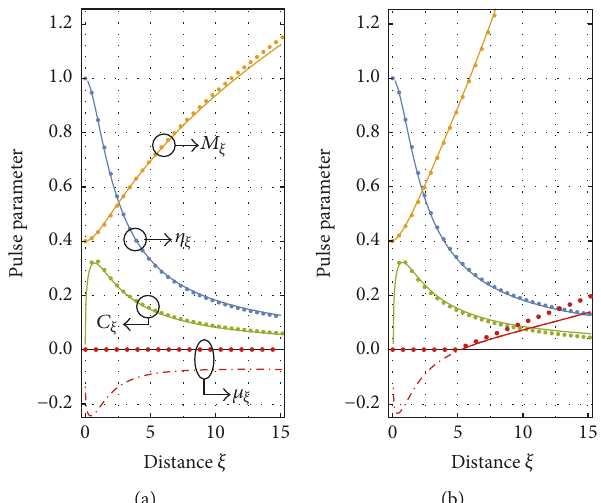
Figure 5: Impact of gain: evolution of amplitude scaling parameter 𝑀 𝜉 (orange), scaling parameter 𝜂 𝜉 (blue), chirp 𝐶 𝜉 (green), and soliton content 𝜇 𝜉 (red) as calculated here (solid/dash-dotted lines) in comparison to numerical simulation (dots). (a) For the integrable NLSE system with 𝛾 = 0 and (b) with gain ( 𝛾 = 0.1 ), soliton appears at 𝜉 𝐵 ≈ 5 . Initial parameters: 𝑁 = 0.4 , 𝜂 = 1 , and 𝐶 = 0